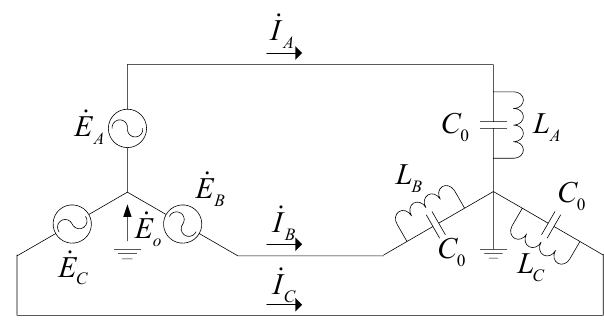
Figure 3. Equivalent circuit of a PT’s